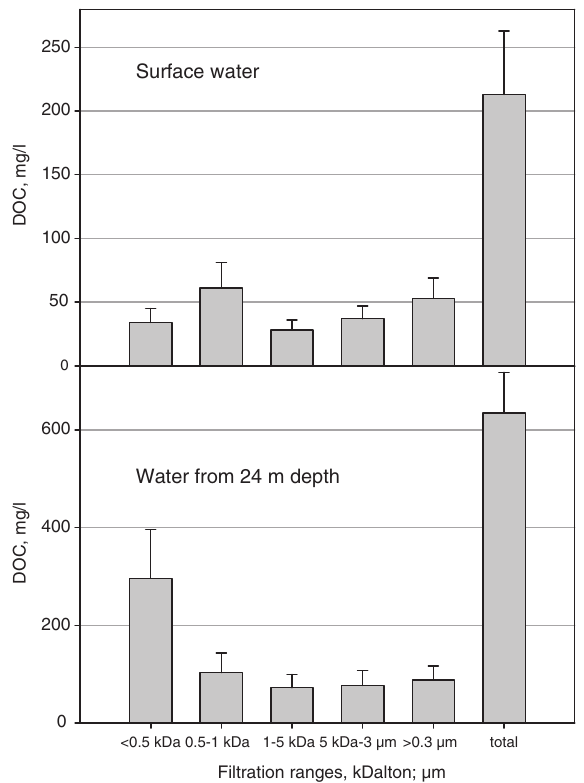
Fig. 2. Molecular size distribution of the DOC in the